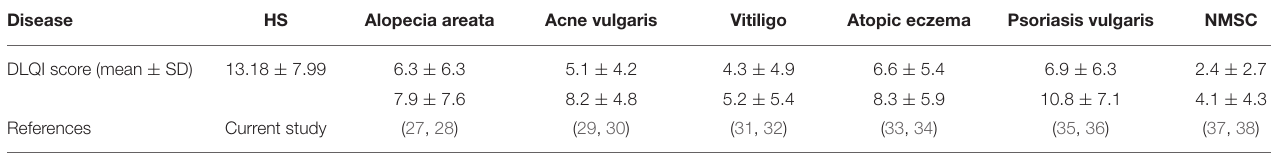
TABLE 4 | DLQI scores reported for different skin disorders.